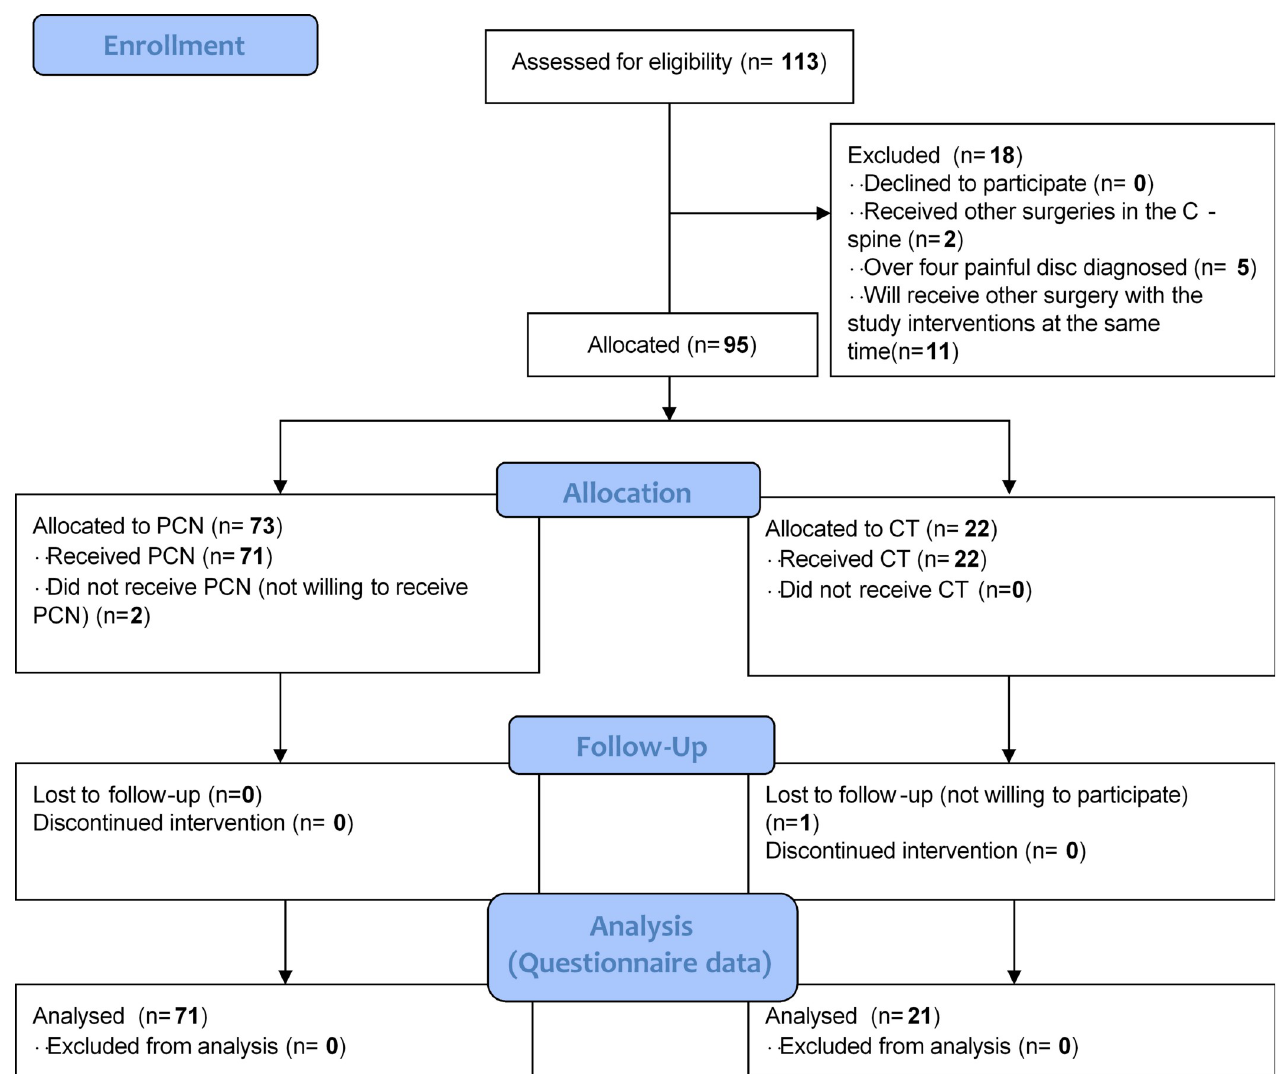
Fig 1. A flow diagram showing patient enrollment and the eligibility criteria applied to the study. PCN: percutaneous cervical nucleoplasty; CT: conservative treatment.